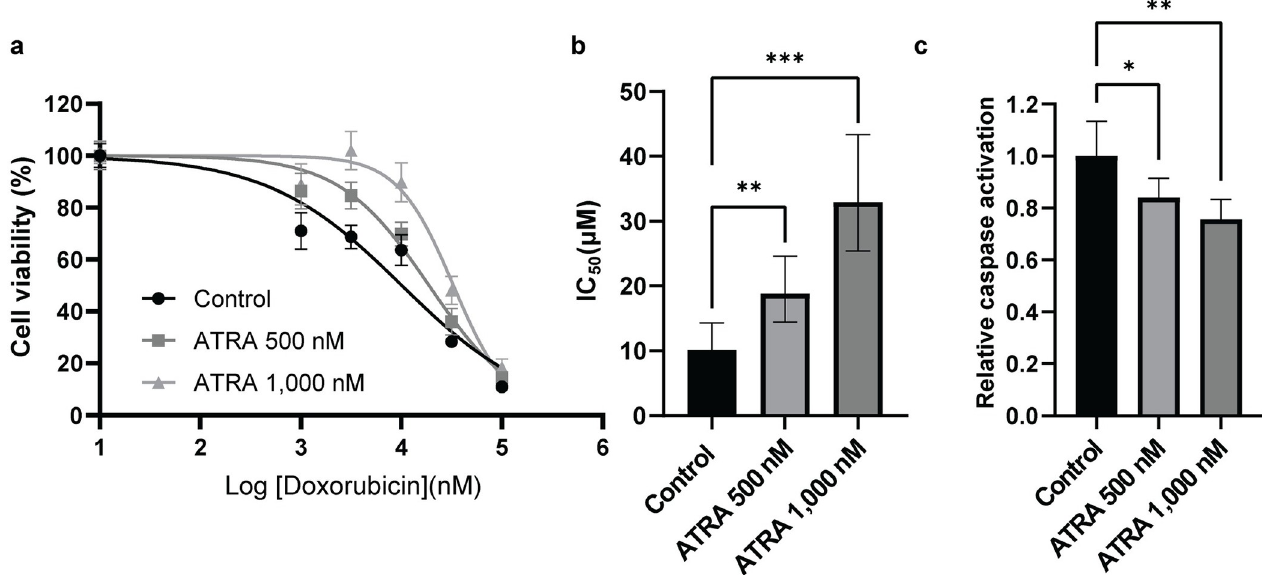
Fig 1. ATRA protects human cardiomyocytes exposed to doxorubicin. (a) Dose-response curves from the MTT cell viability assay. The dose-response curves are plotted for control (vehicle-treated) and ATRA (500 nM, 1000 nM) at serial concentrations (0 μ M, 1 μ M, 3.16 μ M, 10 μ M, 31.6 μ M, and 100 μ M) of doxorubicin (N = 12, 4 independent experiments of 3 biological replicates). Data are presented as mean ± standard error of the mean. (b) IC 50 values corresponding to each cell-viability curve fit. Data are presented as mean and 95% CI (profile likelihood). Extra-sum-of-squares F test was performed to compare the curve fits ( �� , and ��� denote P = 0.0051 and P < 0.0001, respectively). (c) Relative apoptosis activation measured by caspase 3/7 activity assay. The graph shows apoptosis activation relative to 10 μ M doxorubicin vehicle-treated condition. The apoptosis activation was calculated by normalizing to untreated cells in each condition. Relative apoptosis in control (vehicle-treated) and ATRA (500 nM, 1000 nM) at 10 μ M doxorubicin treatment is plotted (N = 6 independent biological replicates). Data are presented as mean ± standard deviation. Statistical analysis was performed using one-way ANOVA with Dunnett’s multiple comparisons correction ( � , and �� denote P = 0.0250 and P = 0.0013, respectively).